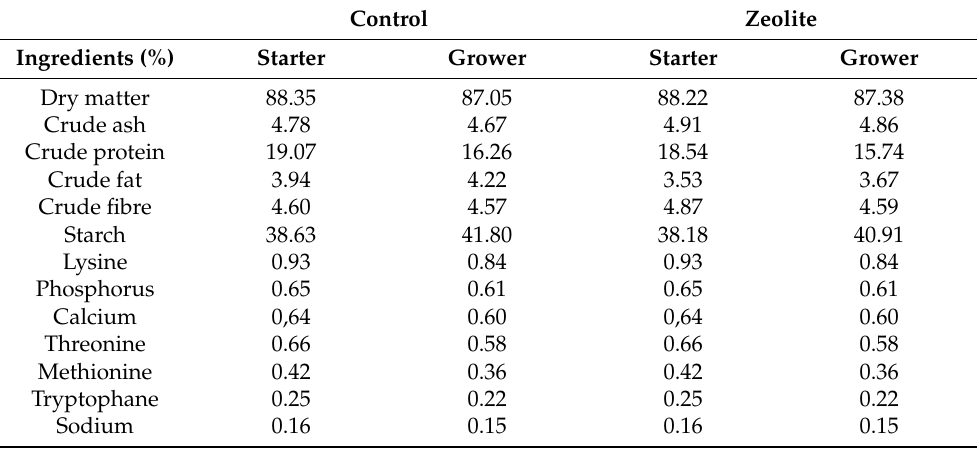
Table 2. Analytical composition of feeds for broiler ducks. Control